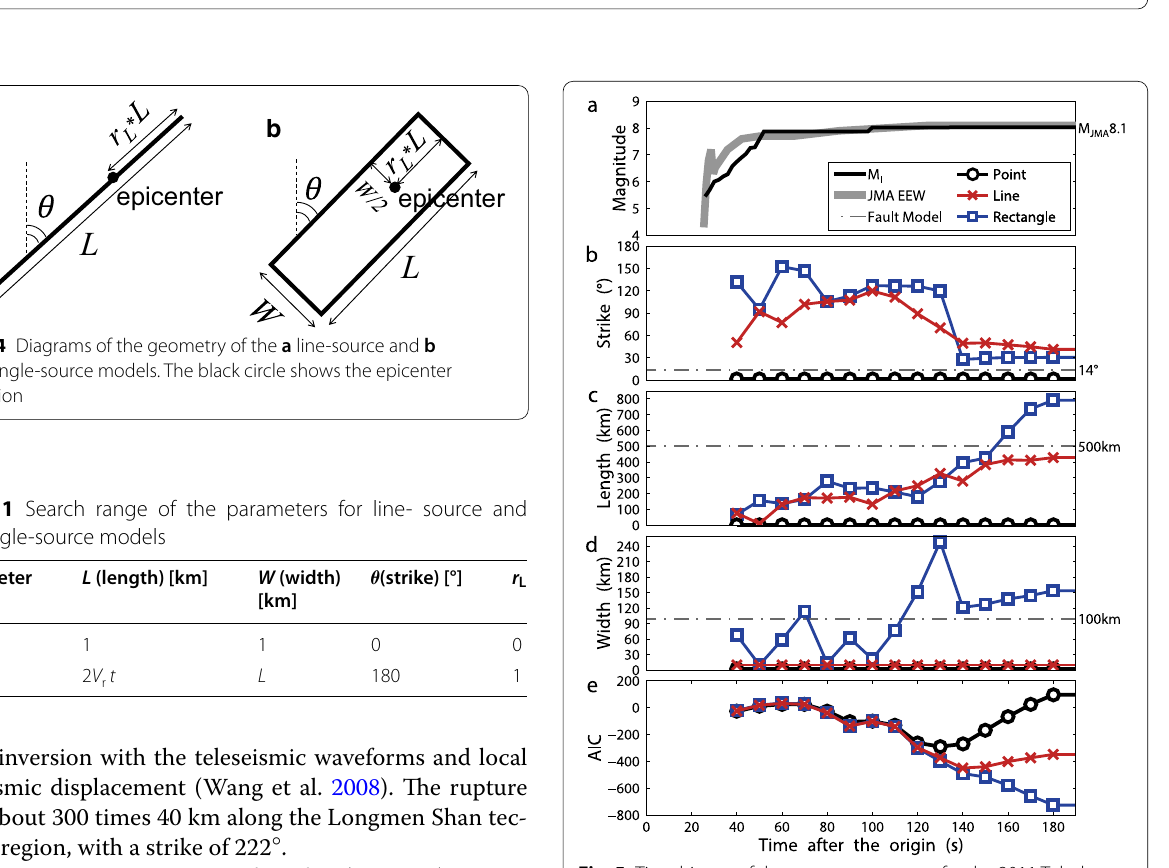
Fig. 3 Flow of XYtracker. The process comprises three steps: (1) obtaining source model parameters from the observed seismic intensity, (2) computing the residual between the observed and estimated intensities, and (3) selecting the most probable model based on AIC